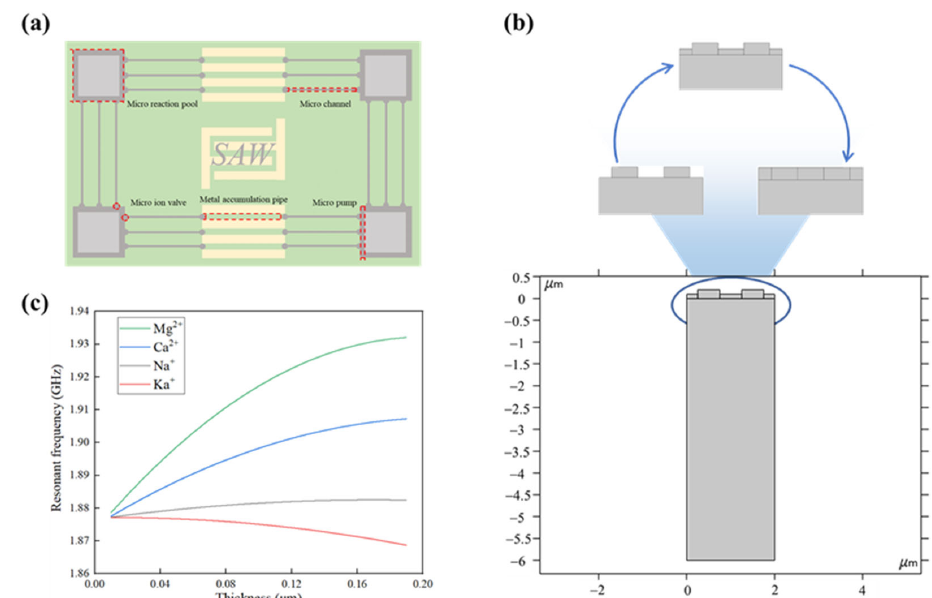
Figure 7. Sweat ion concentration measurement using SAWS. ( a ) Schematic diagram of extracting metal ions from sweat using microfluidic techniques and ion-selective membranes; ( b ) finite element simulation model for measuring sweat ion concentration using SAW; ( c ) the relationship between the resonant frequency of SAW and the thickness of ion accumulation.